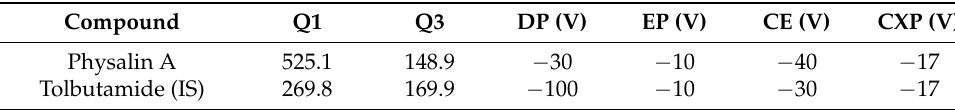
Table 4. Mass scan method parameters of physalin A and